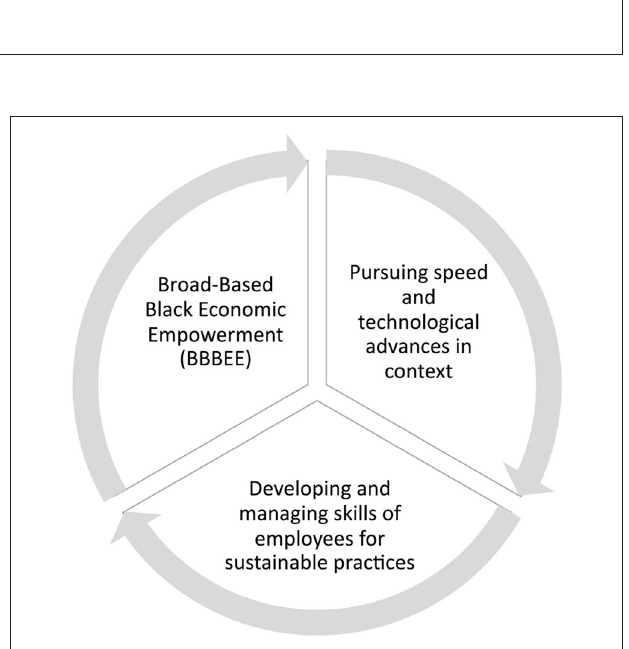
FIGURE 2 | Three positive ways to become a driver of Industry